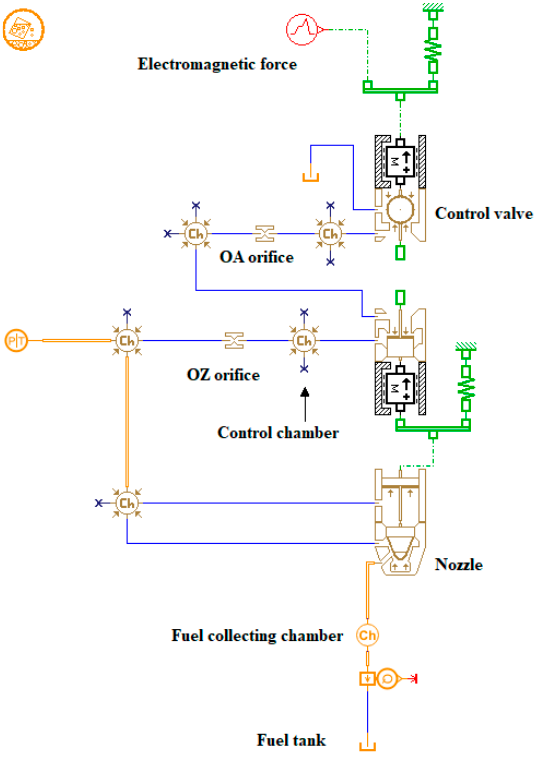
Figure 4. The simulation model of CR injector under adiabatic flow.